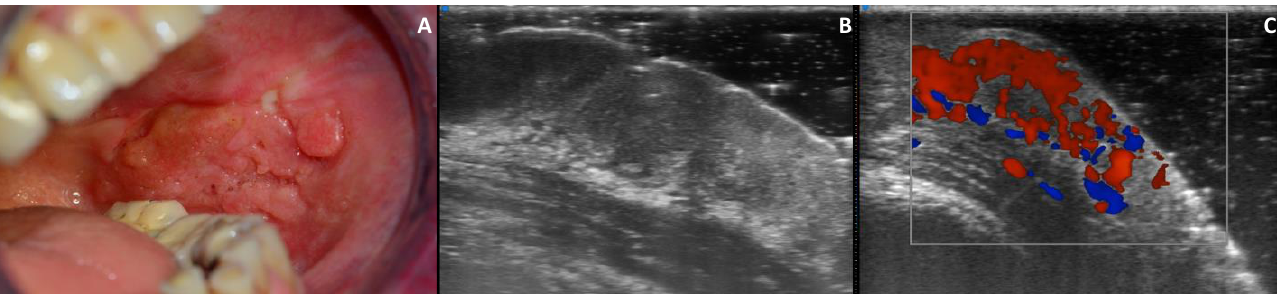
Figure 3. OSCC of the mouth floor in a 56-year-old female: ( A ) clinical aspects of the lesion; ( B ) B-mode UHFUS (ultra- high frequency ultrasound) examination, showing a lobulated exophytic lesion with characteristics of hypoechogenicity compared to the surrounding tissue; the lower margins appear blurred and the lesion seems partially extended to the underlying submucosa; ( C ) color Doppler image, showing intense (score 3) intralesional and perilesional vascularization with diffused aliasing phenomena.